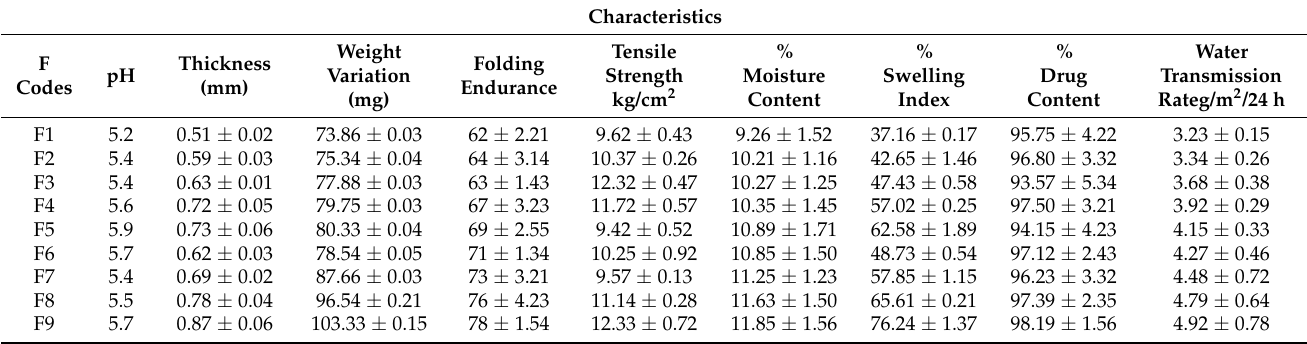
Table 2. Characterization of transdermal patches of methotrexate